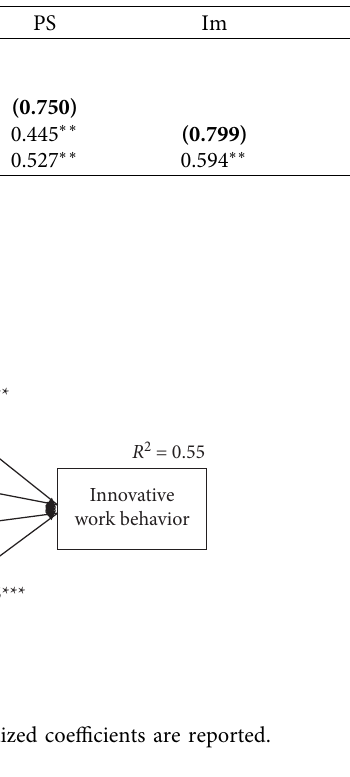
Table 2: Means, standard deviations, reliabilities, and correlations.